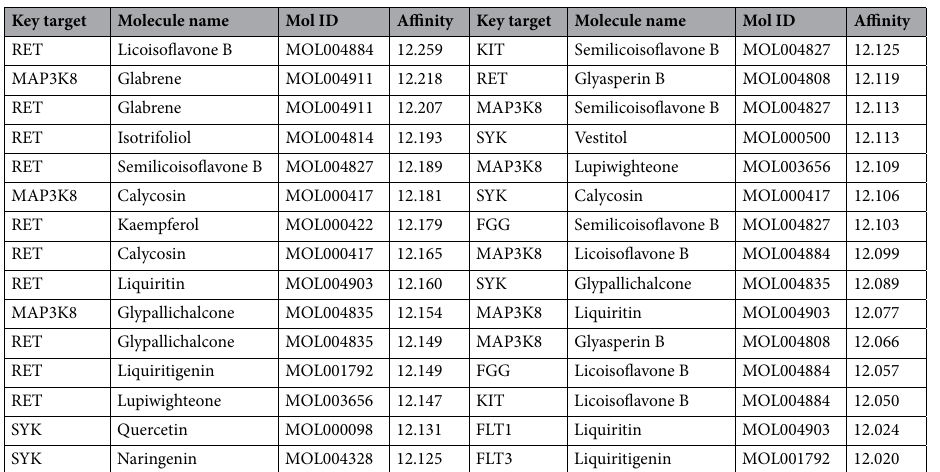
Table 4. Top 30 drug-target pairs obtained by the P3